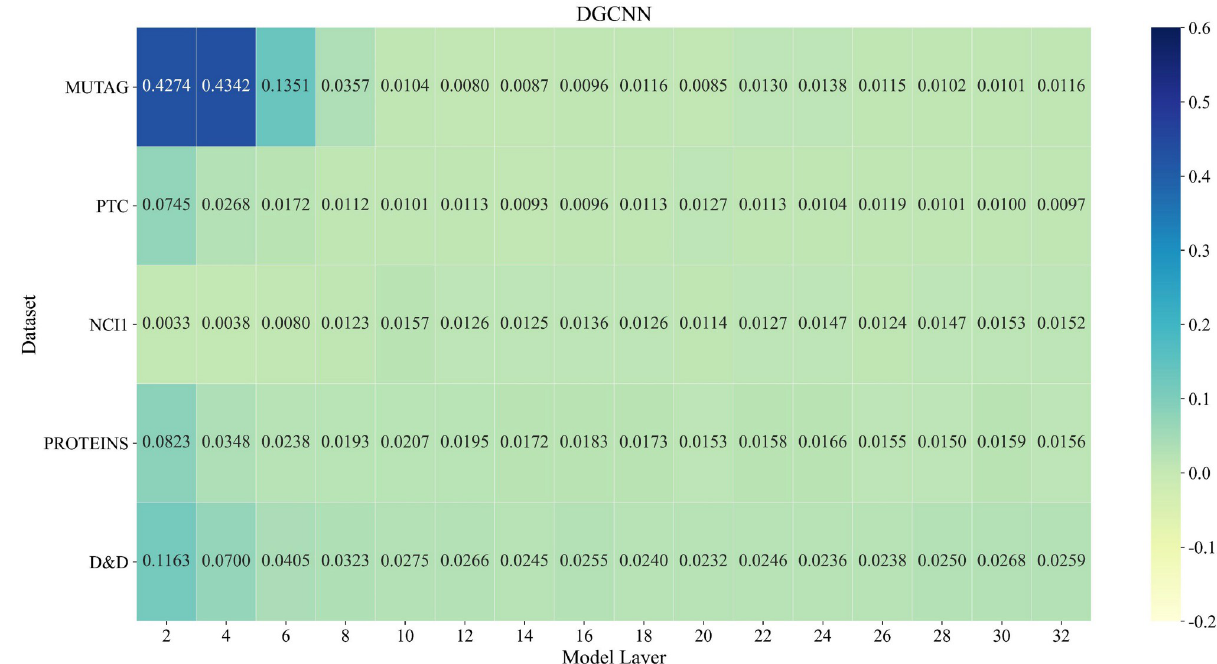
Fig 4. MAD values of different layers of 32-layer DGCNN on 5 datasets. Lighter color means smaller MAD value. We can find that the smoothness of the graph representation increases with the number of model layers, and the over-smoothing phenomenon of DGCNN is significantly more serious than that of